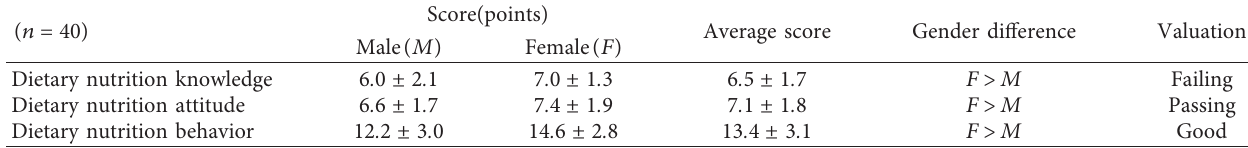
Table 5: Youth trampoline athletes KAP scores and evaluation